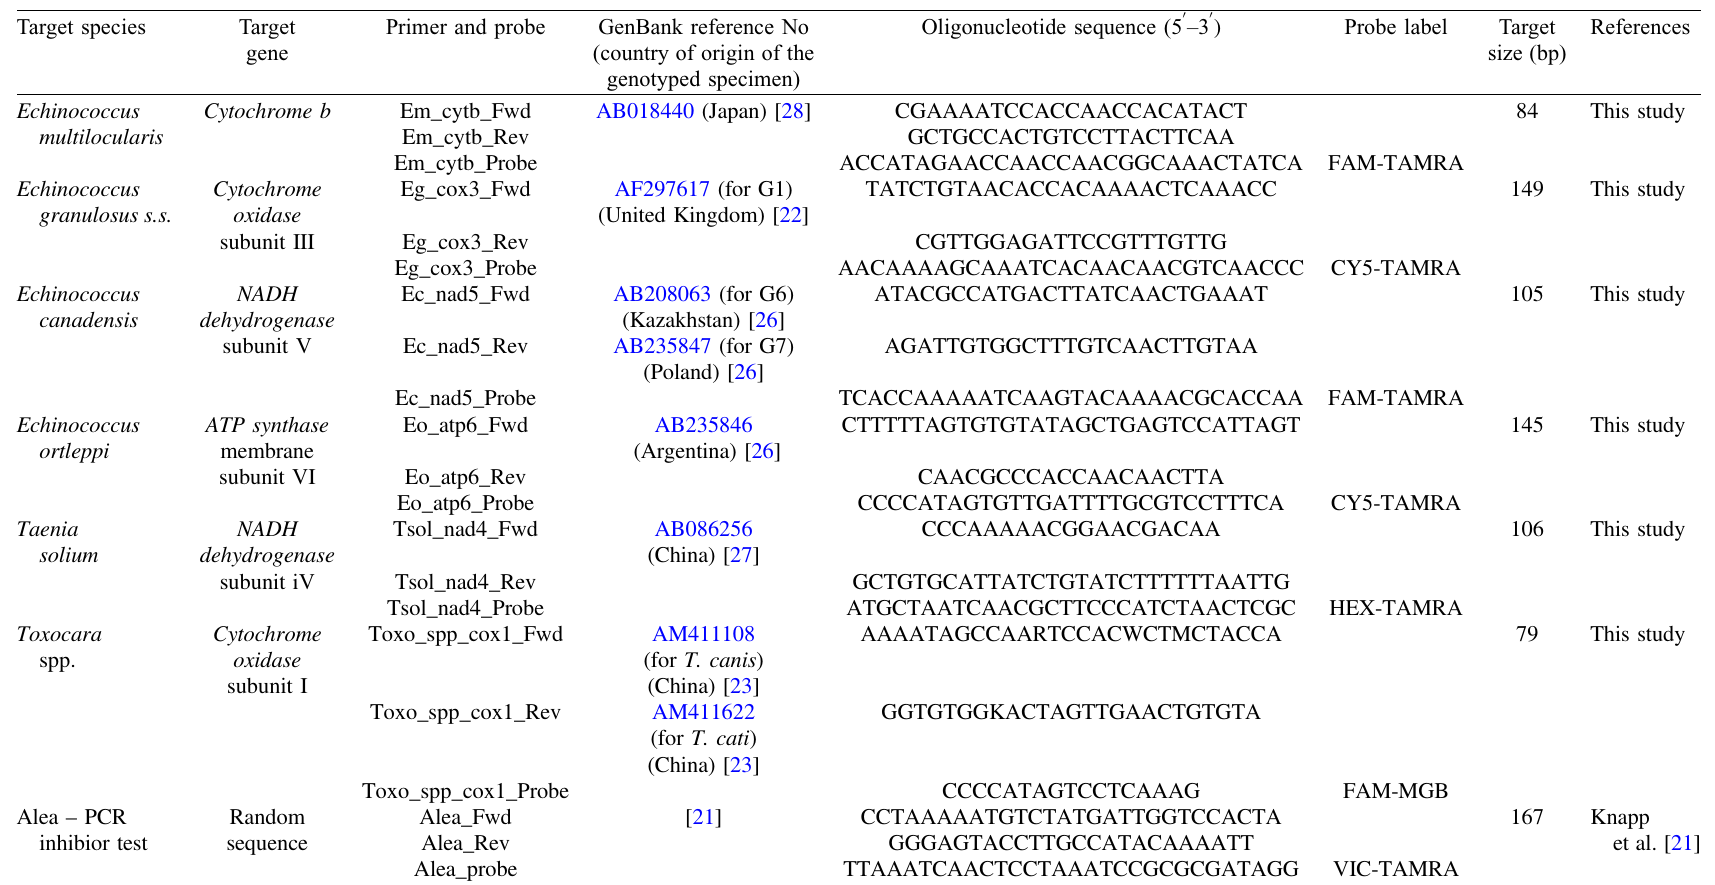
Table 2. Primers and hydrolysis probes designed based on GenBank reference sequences for the targeted parasite detection by